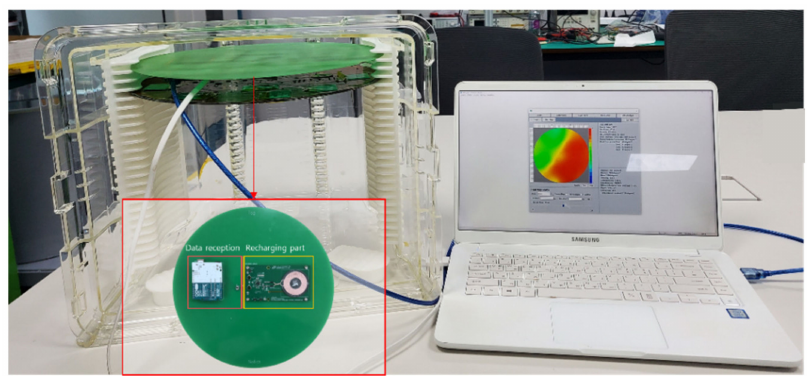
Figure 6. OTMS and UI image during data transmission/reception at the station.